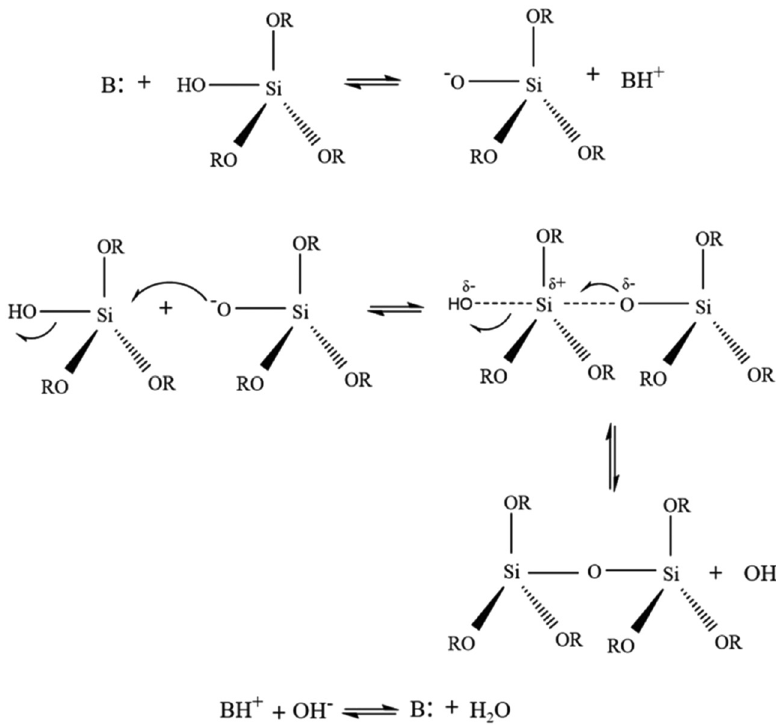
Figure 3: Mechanism of TEOS precursor condensation in base - catalyzed reactions [ 55 ] ; Copyright: 2021 with permission from Elsevier Inc.